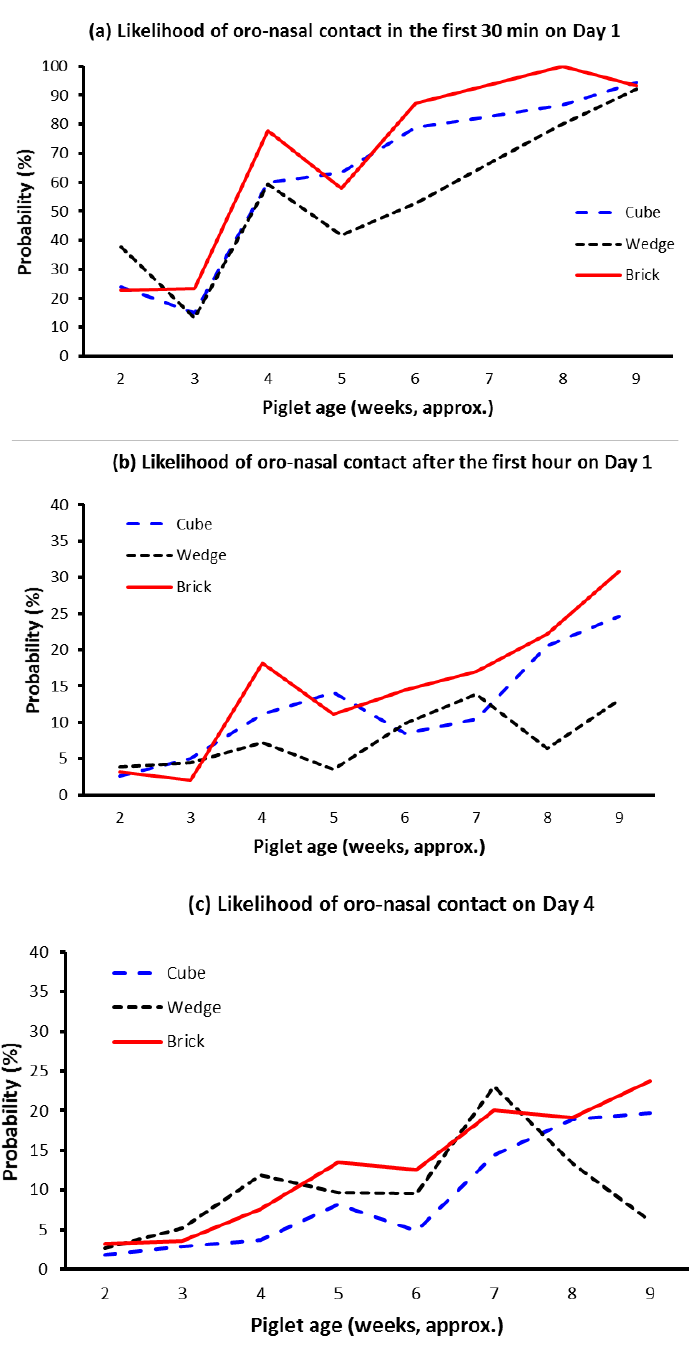
Figure 2. Oro-nasal contact by pigs with enrichment blocks of the three shapes during ( a ) the first 30 min after replacement in the pen, ( b ) during the next 23 h (Day 1), or ( c ) on the fourth day (Day 4). New blocks were provided each week. Values shown are the raw mean probability per treatment (shape) over time. Pigs were weaned at about age 28 days.